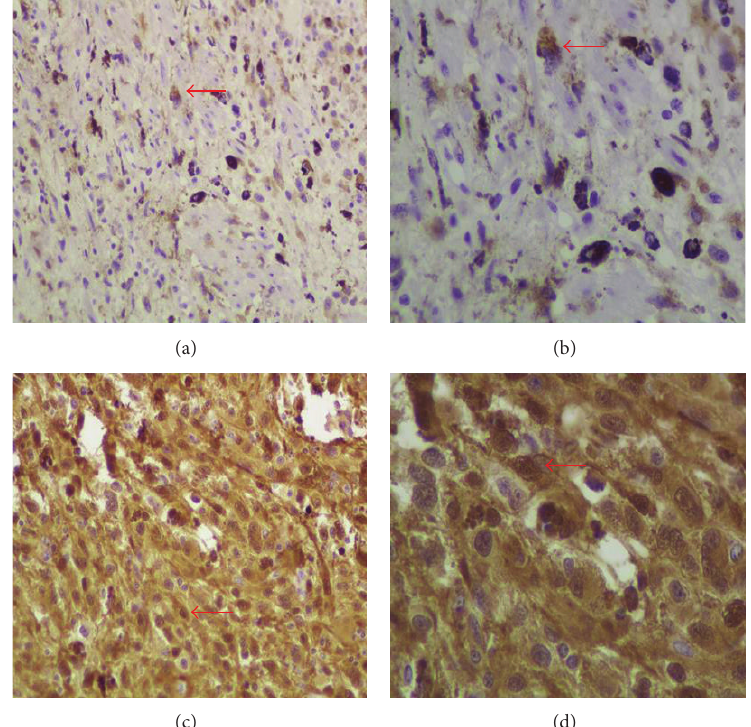
Figure3:Immunophenotypeoftumorcells.TheneoplasticcellsexpressedmelanA((a,b)redarrows)andS-100((c,d)redarrows)(Streptavi- din peroxidase (a, c) × 200, (b, d) ×